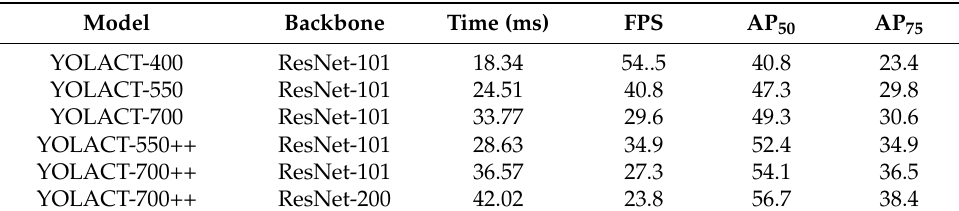
Table 5. The performance comparison among different settings of YOLCAT-based models.